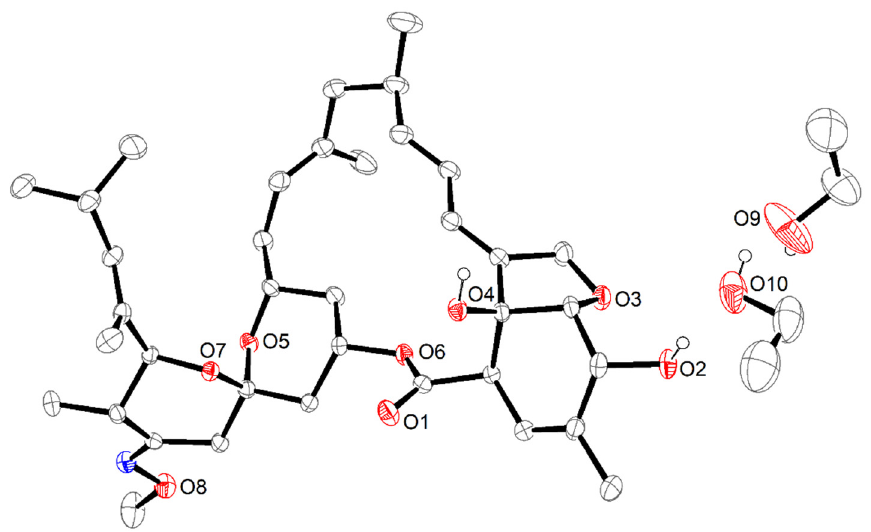
Figure 2. Asymmetric unit in the crystal structure of the ethanol solvate (Moxi · 2EtOH) containing the molecular structures of moxidectin and two independent ethanol molecules shown with anisotropic displacement parameters (ADPs). ADPs are shown with 50% probability. Color code: C, grey; N, blue; O, red; H, white.